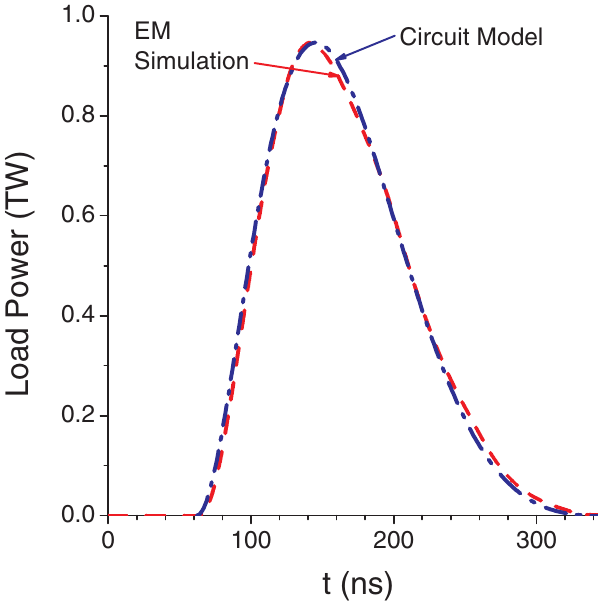
FIG. 8. (Color) Total load power as a function of time for the ten-cavity LTD system as calculated from the circuit model (blue) with the R C ð t Þ core loss model and from the 3D LSP simulation model